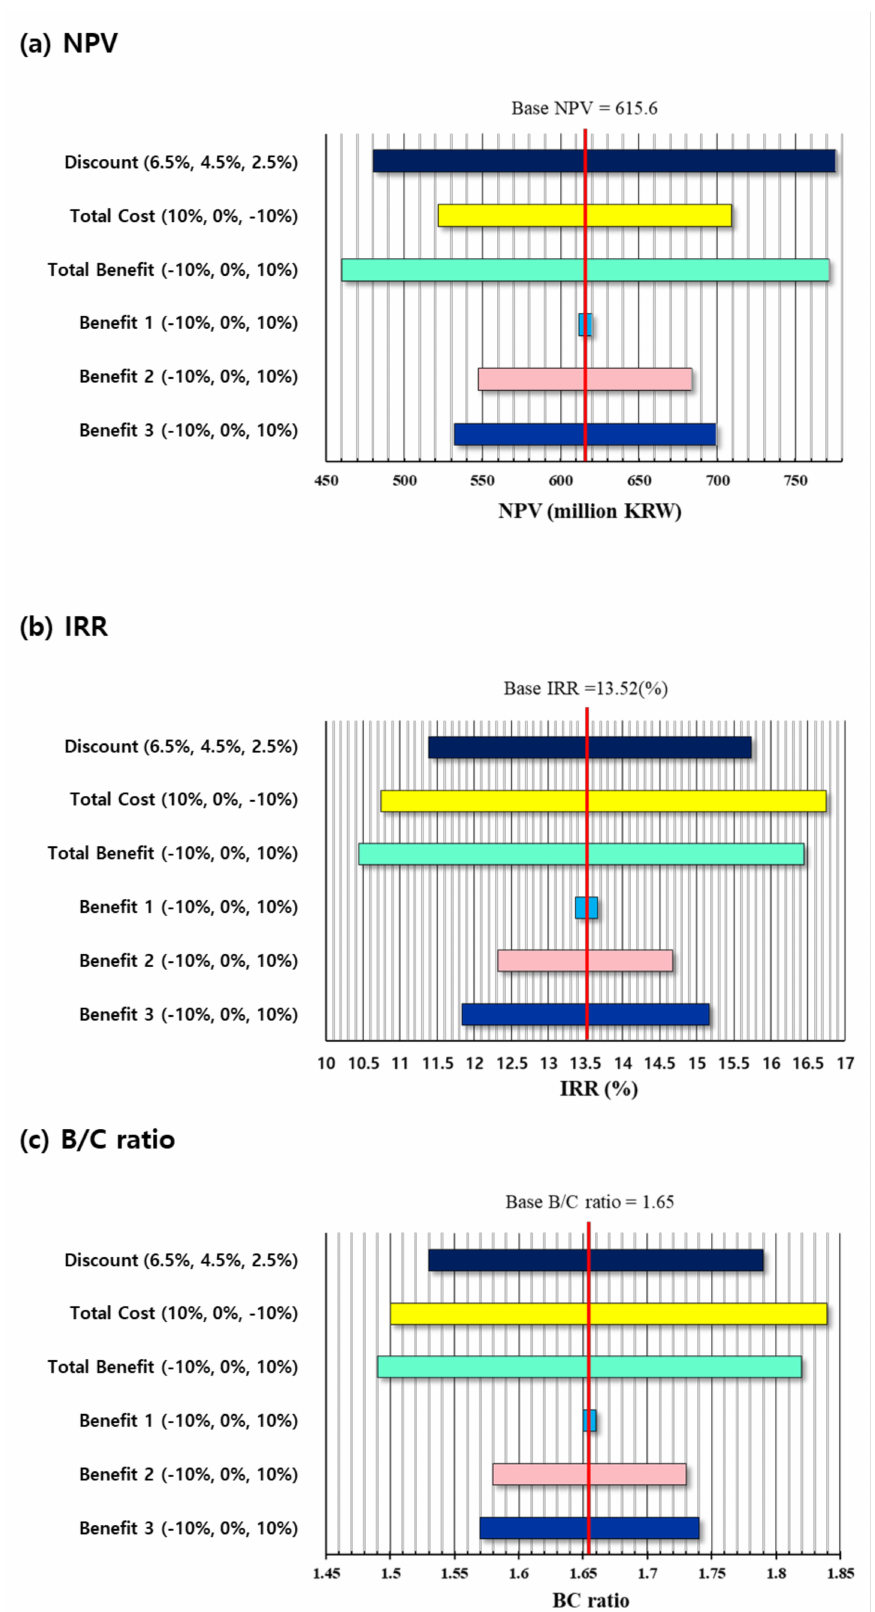
Figure 2. Sensitivity analysis result of each parameter. ( a ) net present value (NPV) results; ( b ) internal rate of return (IRR) results; ( c ) benefit/cost (B/C) ratio